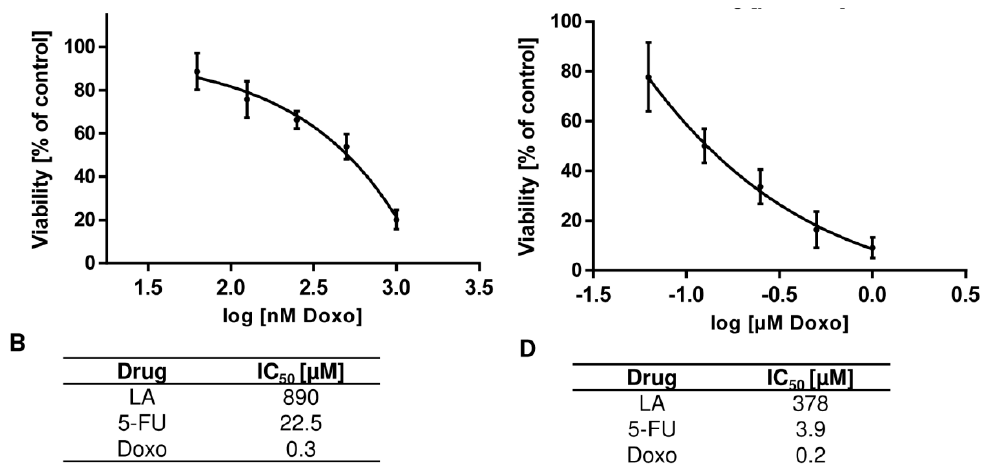
Figure A4. Determination of drug concentrations for application of the Chou–Talalay method. HCT116-p53 − / − (left panel) and RKO (right panel) cells were treated with increasing fixed-ratio doses of ( A ) LA for 120 h or 5-FU / Doxo for 72 h respectively. Cell viability was measured using ATP assays and normalized to solvent treated control cells. Drug concentrations were transformed into log-scale and plotted against the cell viability. The curve was fitted by non-linear regression with variable slope, providing the IC 50 -values. Data are presented as mean + SEM, n = 2, triplicates. ( B ) Summary of IC 50 -values.